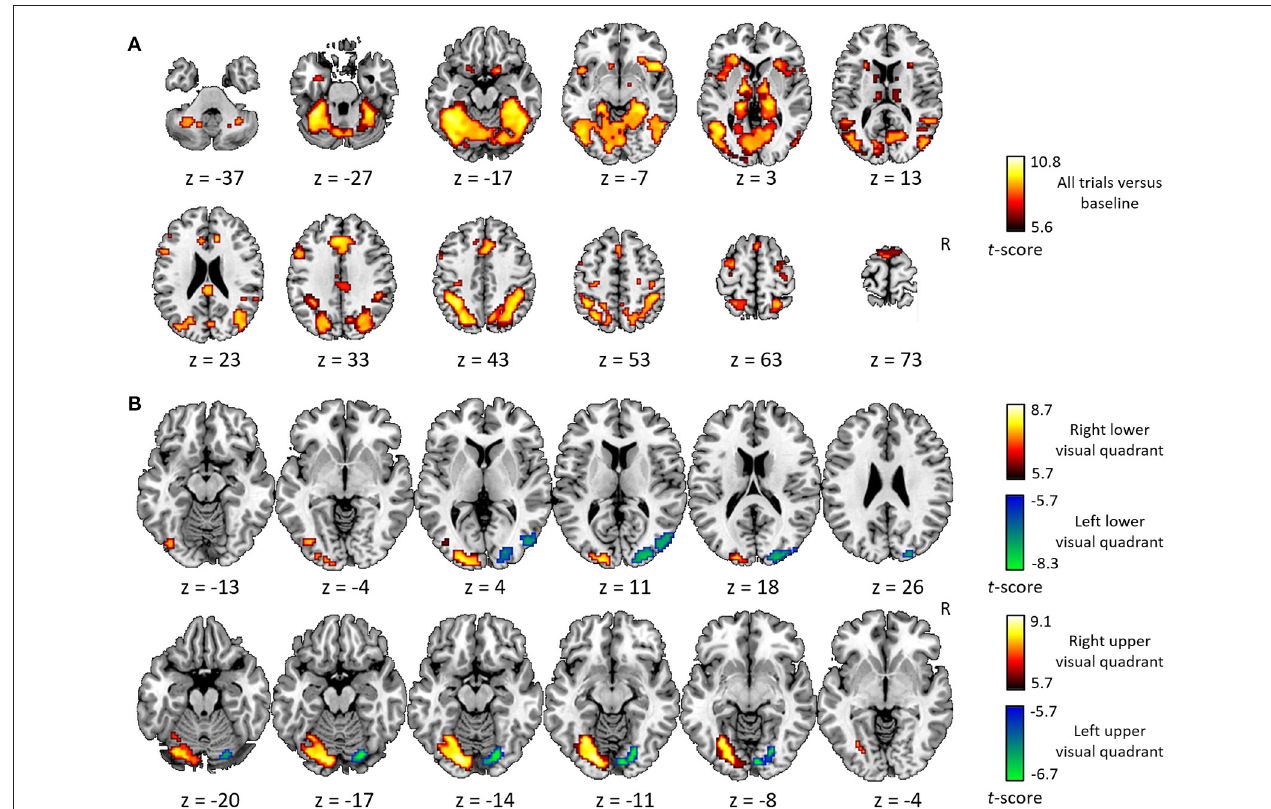
FIGURE 3 | Univariate analysis. (A) Axial slices depicting the univariate contrast of all stimuli compared to baseline. (B) Axial slices depicting for each quadrant the univariate contrast with the three other quadrants. Results for the left visual field are displayed in green-blue and results for the right visual field in red-yellow, for the lower visual field (upper row) and the upper visual field (lower row). Voxel-level inference threshold of FWE whole-brain corrected P < 0.05.